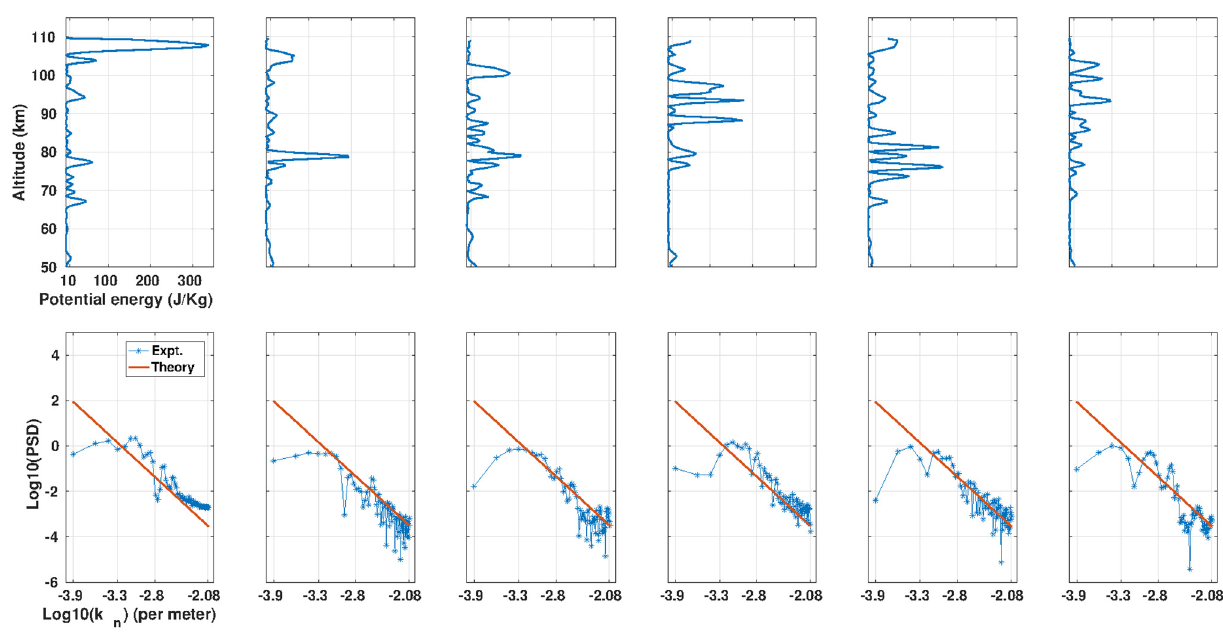
Figure 7. Potential energy of the gravity wave ( top panels ) versus altitude and logarithm of theoretical ( red line ) and experimental ( lines with asterisks ) power spectral density normalized temperature perturbation versus the logarithm of the vertical wave number of atmospheric gravity wave ( bottom panels ) on 15 October 2011.